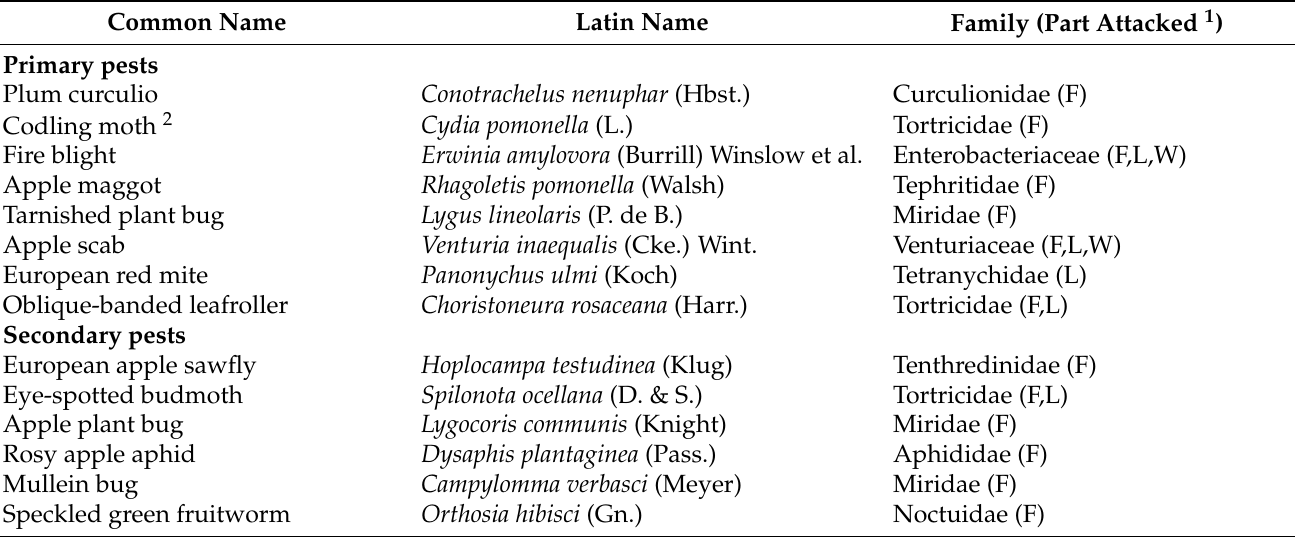
Table 1. Diseases and arthropod pests monitored by the Quebec Apple Network from 1977 to